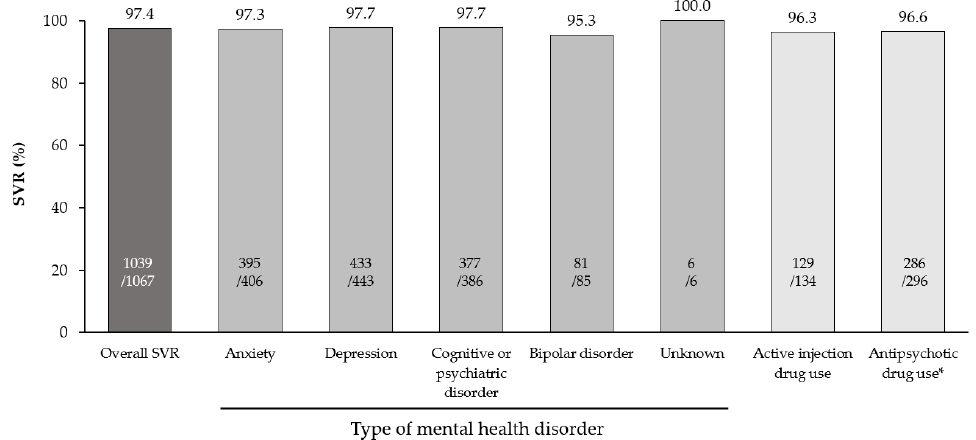
Figure 2. SVR in the effectiveness population, stratified by type of mental health disorder and complicating baseline characteristics. * For 21 patients in the EP, aggregated data for SVR were provided, without breakdown for anti-psychotic drug use. Abbreviations: EP: effectiveness population; SVR: sustained virological response.